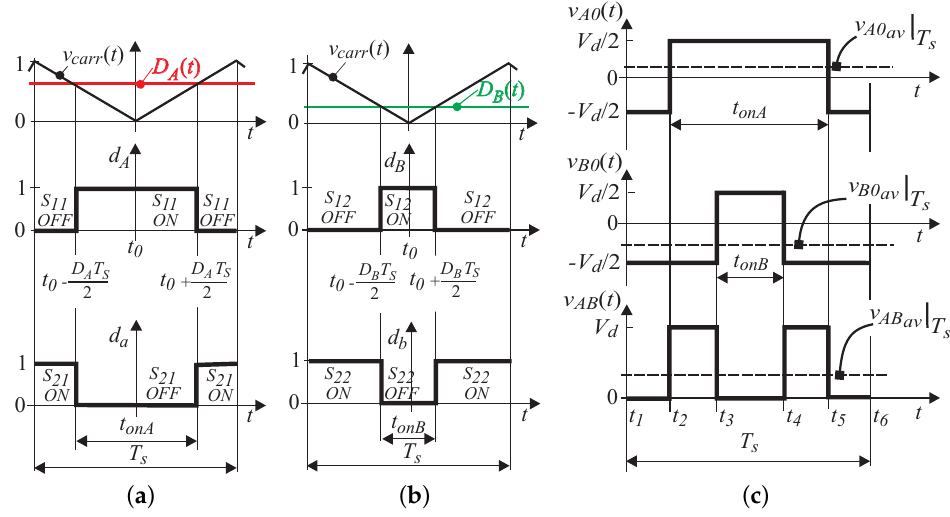
Figure 3. Three level switching functions generation ( a , b ) and, output voltages on the interval T S ( c ): v A 0 ( t ) , v B 0 ( t ) and v AB ( t ) .